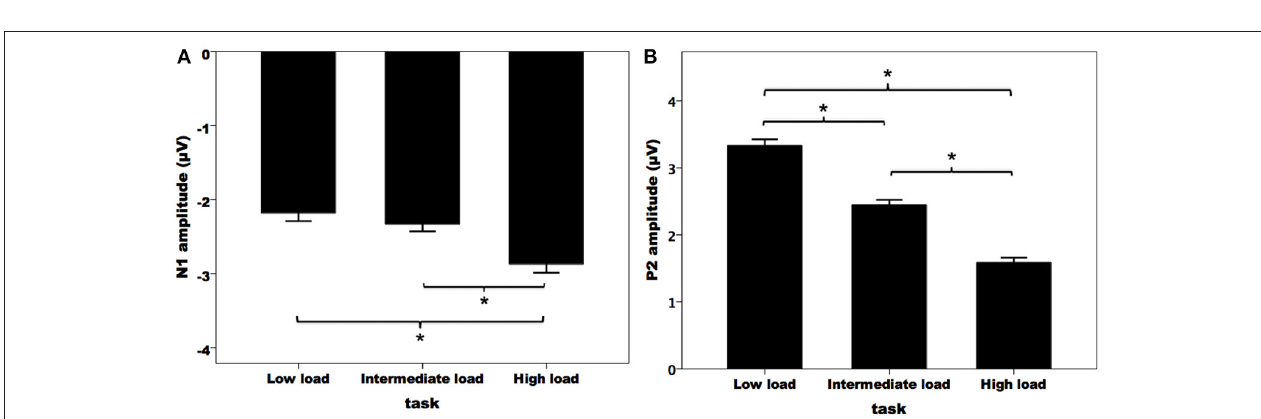
FIGURE 3 | Grand-averaged ERP waveforms (A) and topographical distributions of the N1 (B) and P2 amplitudes (C) in response to pitch perturbations across the three attentional loads. The black, blue, and red solid lines denote the cortical responses during the low-load, intermediate-load, and high-load conditions of divided attention,